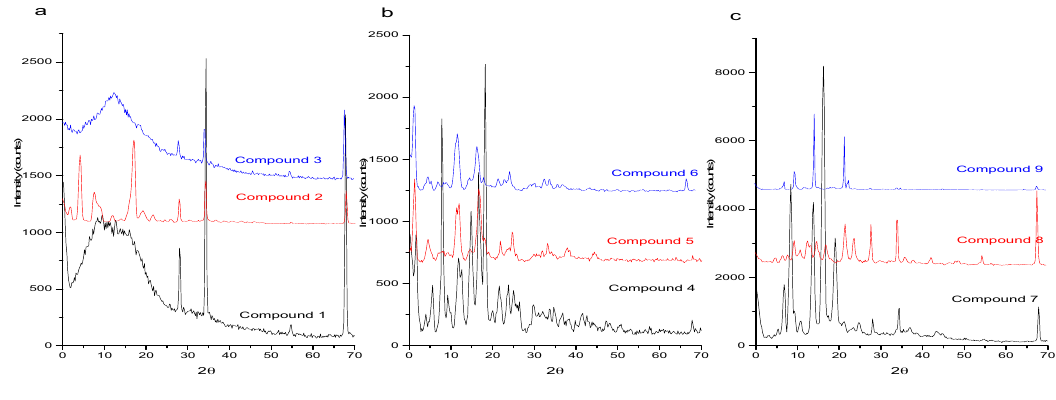
Figure 3. ( a – c ) Diffractogram of Schiff bases 1 – 9 .